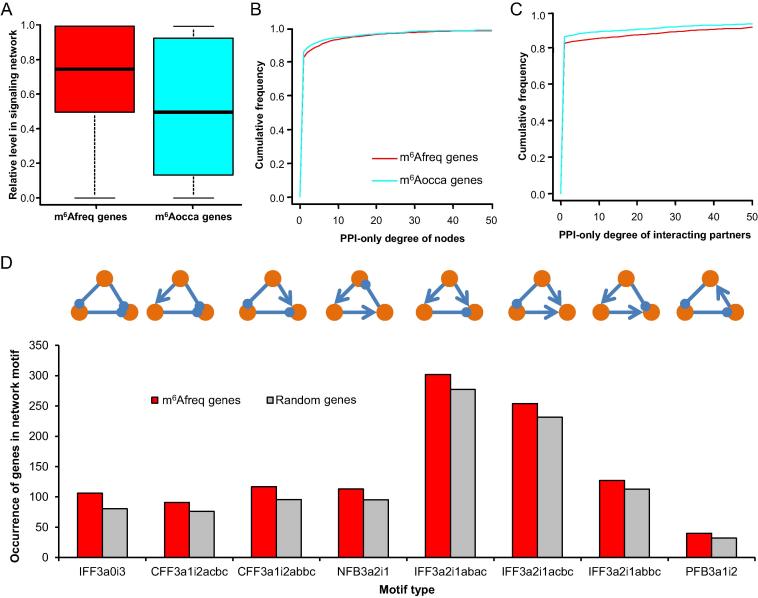
The network feature of the m6Afreq genesA. Boxplot comparing the distributions of relative level in the signaling network, between the m6Afreq genes and m6Aocca genes. The relative level in the signaling network shown here was calculated as the shortest distance to any upstream receptor divided by the sum of the shortest distance to any upstream receptor and the shortest distance to any downstream transcriptional factors. B. Cumulative distribution plot comparing the PPI-only degree distribution of the m6Afreq genes and that of m6Aocca genes. The PPI-only degree only considers PPI edges in the signaling network but omits the activating and repressing edges. C. Cumulative distribution plot comparing the PPI-only degree distribution of the interacting partners of m6Afreq genes and that of the interacting partners of m6Aocca genes. D. The overrepresented network motifs of m6Afreq genes. In a network motif, if there are more m6Afreq genes than 9500 out of 10,000 sets of randomly picked genes (corresponding to an empirical P value < 0.05), this motif is considered as an overrepresented motif. The respective motifs are explicitly depicted by the schemas on top. The activating and repressing edges are indicated using lines with arrowhead and circle, respectively. The name of the motif is composed of the motif type and the code describing the edge topology in the motif. For example, IFF3a1i2abbc indicates an incoherent feedforward loop with three nodes (a, b, and c) that form one activating edge and two repressing edges. Among the three edges, the major class of the edges (in this motif, the major class is repressing edge) comprises the edge between a and b, and the edge between b and c. IFF, incoherent feedforward loop; CFF, coherent feedforward loop; NFB, negative feedback loop; PFB, positive feedback loop.